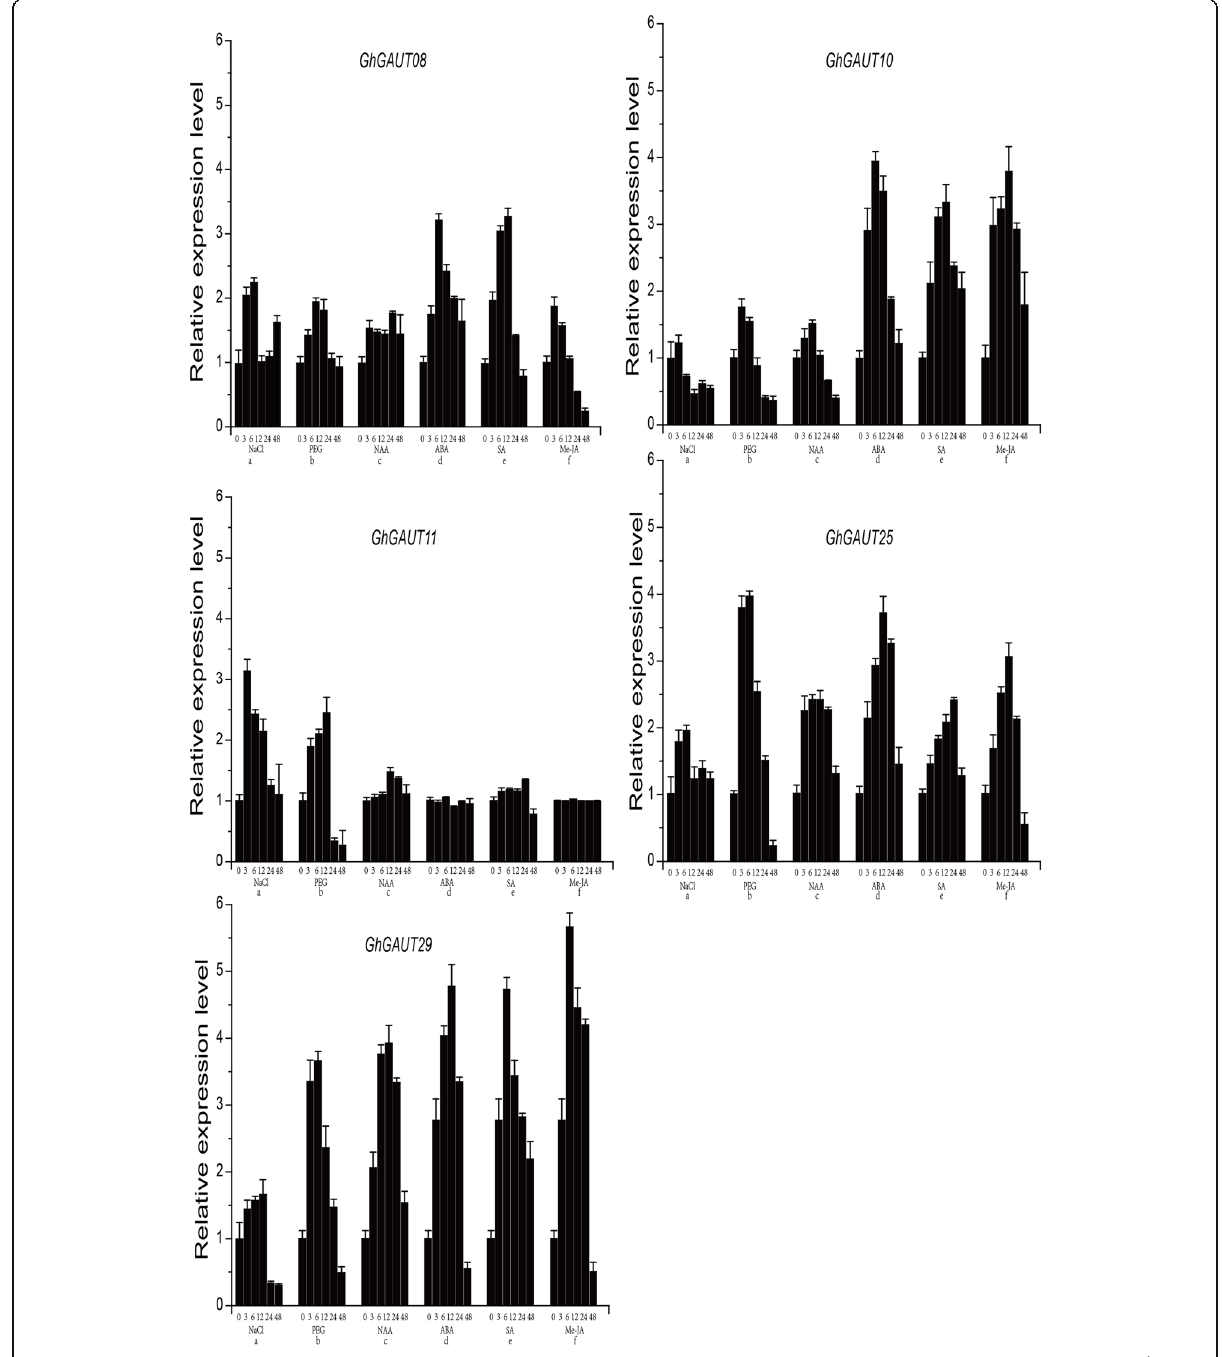
Fig. 8 Analysis of GhGAUT s transcript levels with abiotic stress and phytohormone treatments according to a qRT-PCR assay. a : 200 μ mol·L – 1